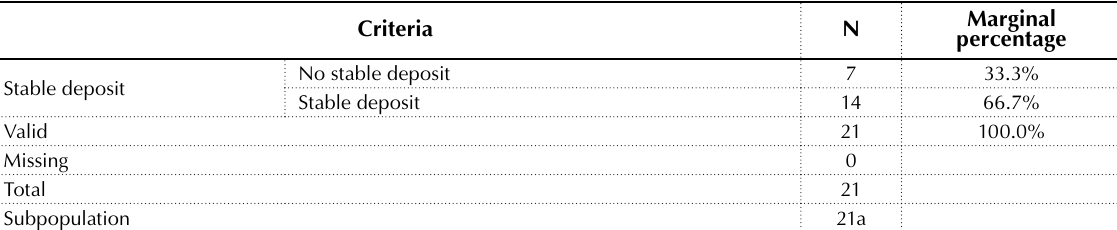
Table 33. Case processing